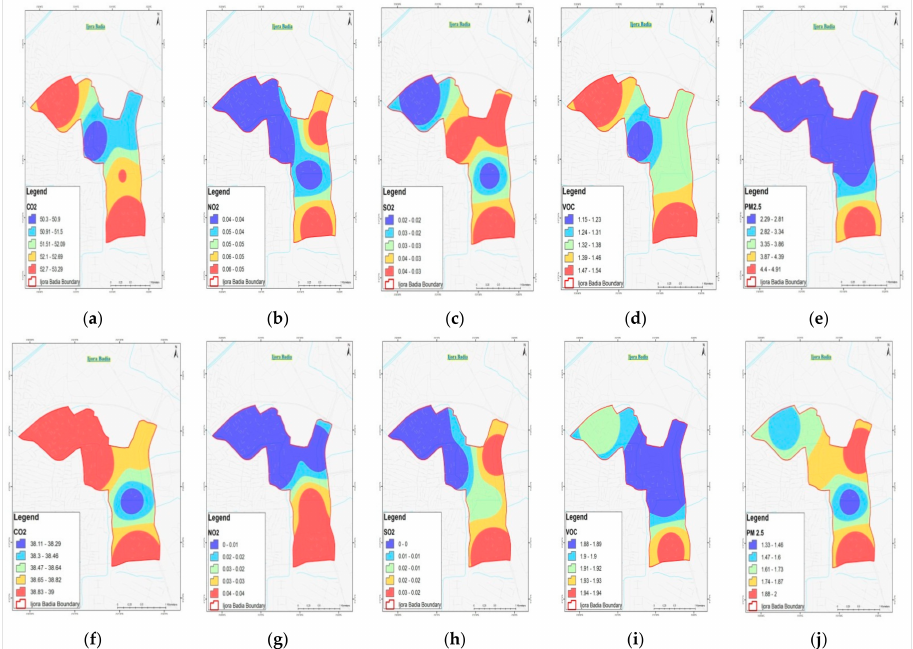
Figure 4. Dispersal pattern of air pollutant concentrations from the Ijora-Badia slum settlement from 2018 to 2019 during the wet and dry season sampling periods, showing areas with hot and cold spots marked with different colors on the map, representing the pollution level. ( a ) CO 2 mg/m 3 Dry; ( b ) NO 2 mg/m 3 Dry; ( c ) SO 2 mg/m 3 Dry; ( d ) VOC mg/m 3 Dry; ( e ) PM 2.5 µ g/m 3 Dry; ( f ) CO 2 mg/m 3 Wet; ( g ) NO 2 mg/m 3 Wet; ( h ) SO 2 mg/m 3 Wet; ( i ) VOC mg/m 3 Wet;